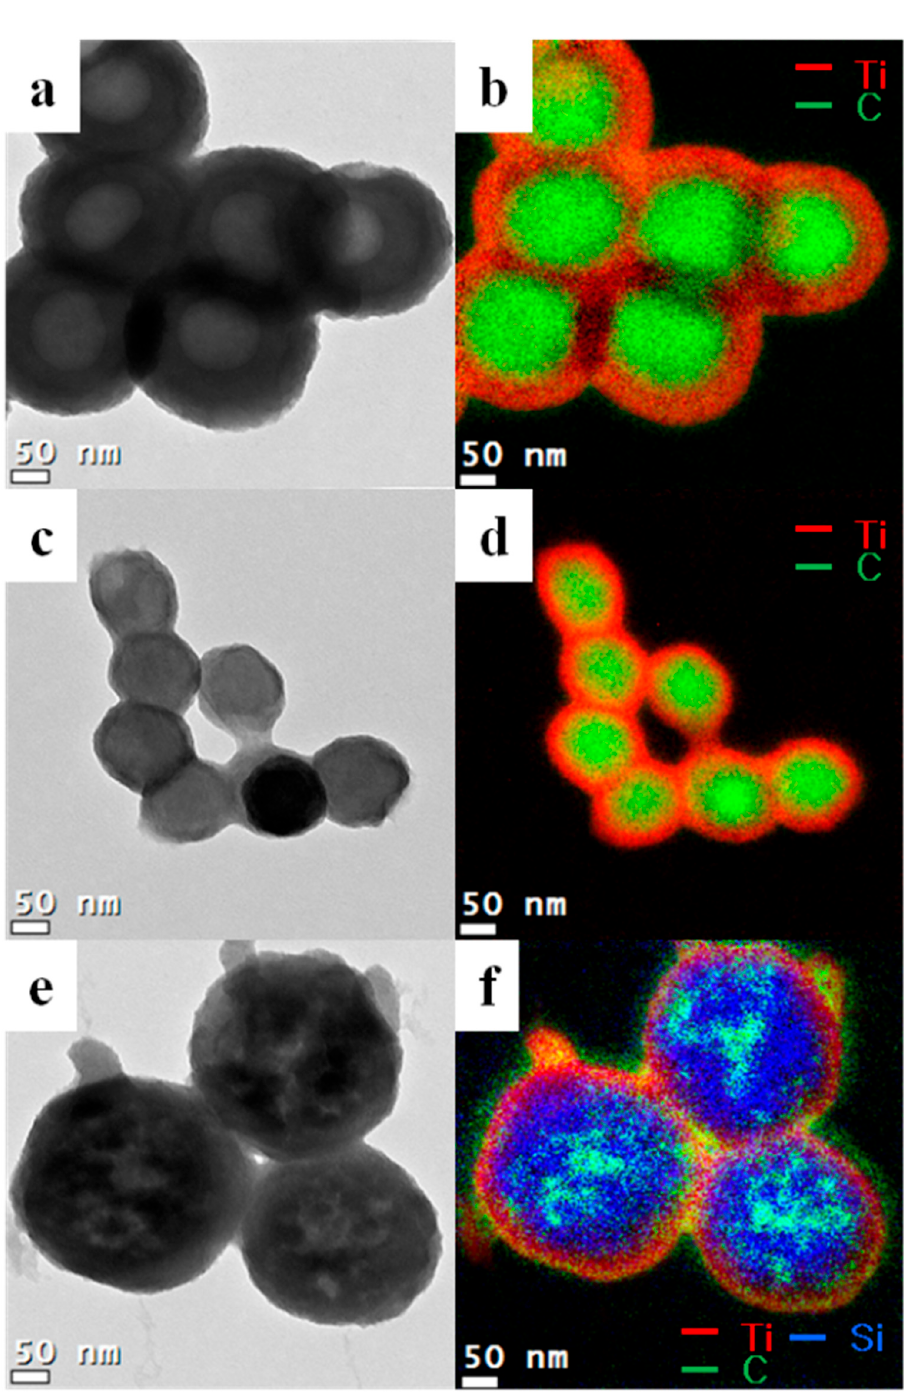
Figure 4. TEM images of core-shell-structured titania spheres ( a ) CS1; ( c ) CS2 and ( e ) CS3. Electron energy loss spectroscopy (EELS) mapping of synthesized titania ( b ) CS1; ( d ) CS2 and ( f ) CS3. The red lines show the Ti atoms, green lines show the carbon atoms, and blue lines show the silicon atoms.